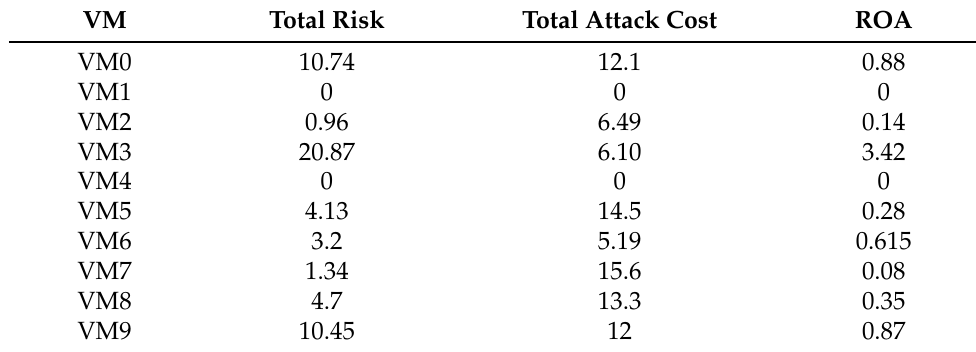
Table 5. VMs’ risk, attack cost and ROA before applying shuffle MtD.